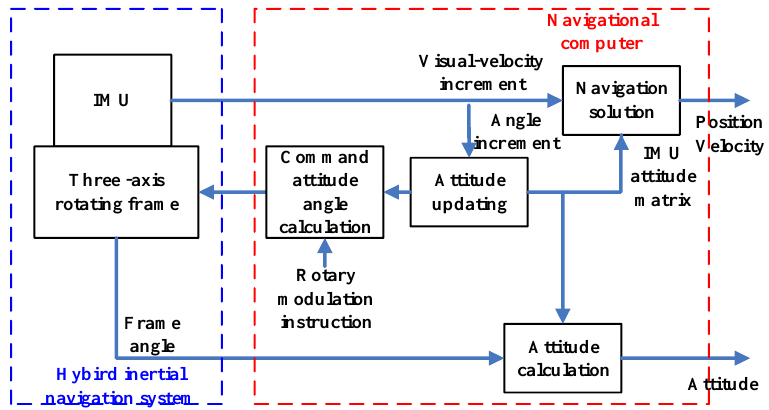
Figure 1. Working principle of the hybrid inertial navigation system.